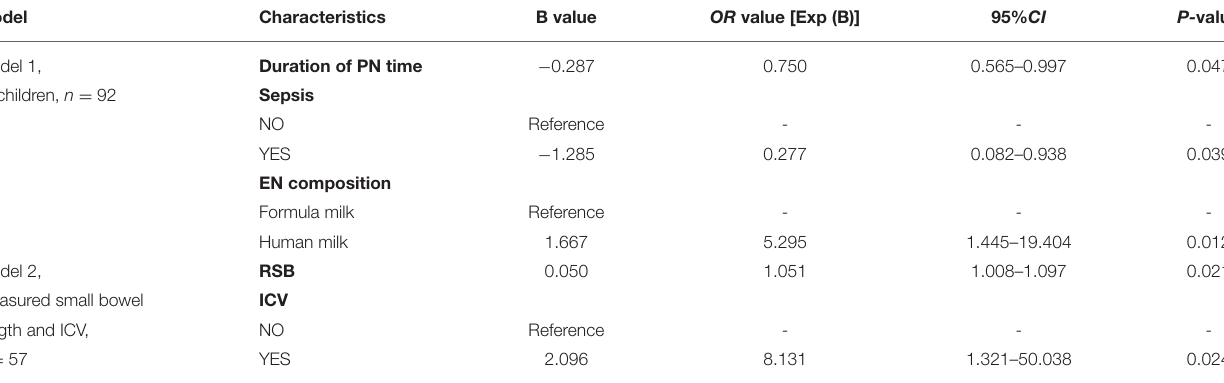
TABLE 4 | Multivariable logistic regression analysis based on the primary outcome of achievement of enteral autonomy in children with intestinal failure.